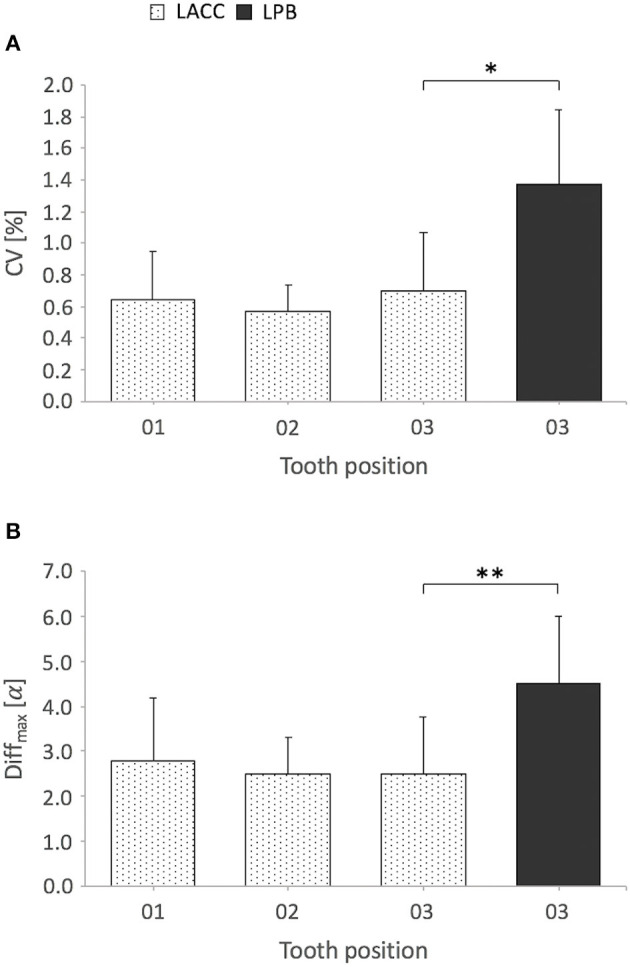
Mean coefficient of variation (CV) and mean maximum angular difference (Diffmax) of repeated interincisal angulation measurements by measuring method and tooth position. Bar plots display mean + SD (error bars); α, alpha angle degrees. Cephalometric determination of the angle encompassed by the respective labial axis of the clinical crown (LACC) of opposing third incisor teeth exhibited a significantly lower CV (A) and Diffmax
(B) compared to the reference method that uses reconstruction of the lingual and palatal border (LPB); *P = 0.017, **P = 0.030, Student's t-test for paired samples, n = 9 horses (missing LBP observation horse 1). Comparing tooth positions 01-03 for LACC reconstructions, there was no significant difference in the CV (A) and Diffmax
(B): CV, P = 0.312, Diffmax, P = 0.860, one-way repeated measures ANOVA, n = 10 horses (LACC observation horse 1 included), sphericity assumed.